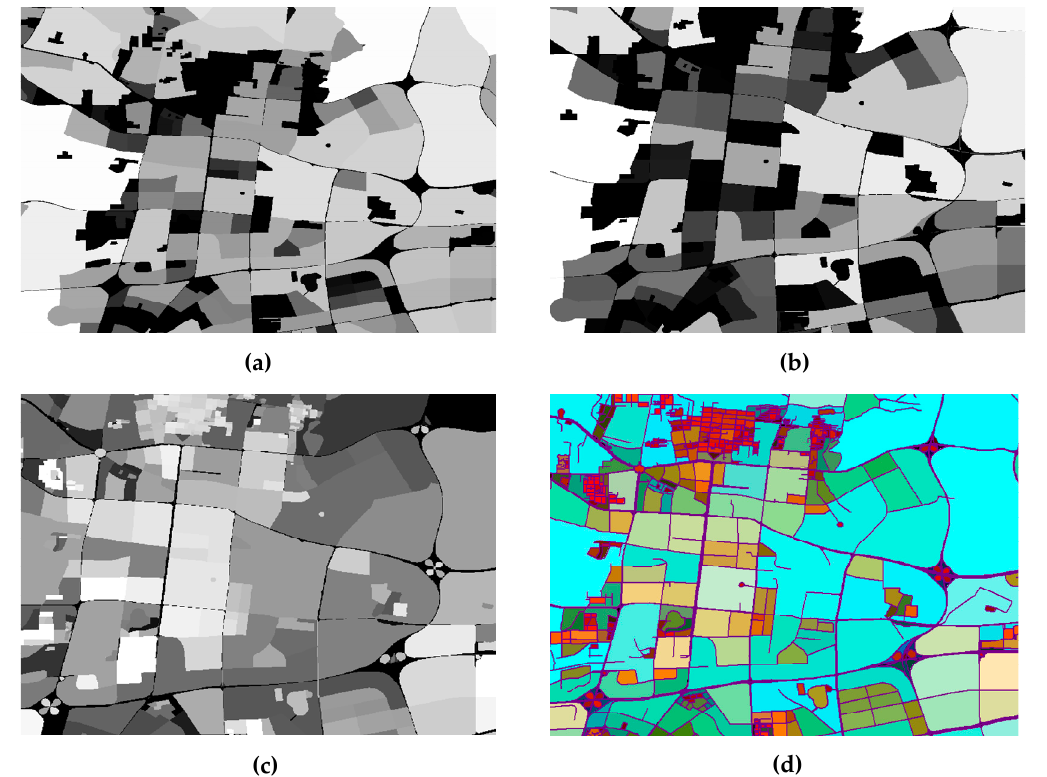
Figure 6. ( a – c ) the raster image with one geometric metric; ( d ) the raster image with three geometric metrics as RGB bands.